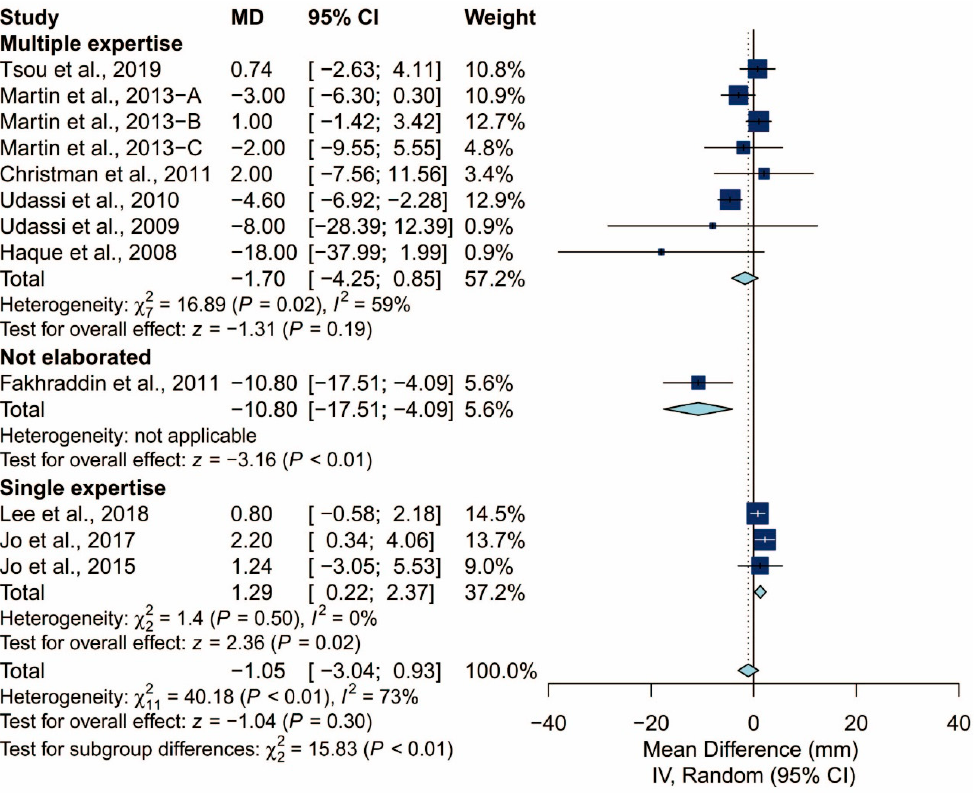
Figure 10. Subgroup analysis of chest compression rate grouped by expertise of the participants.